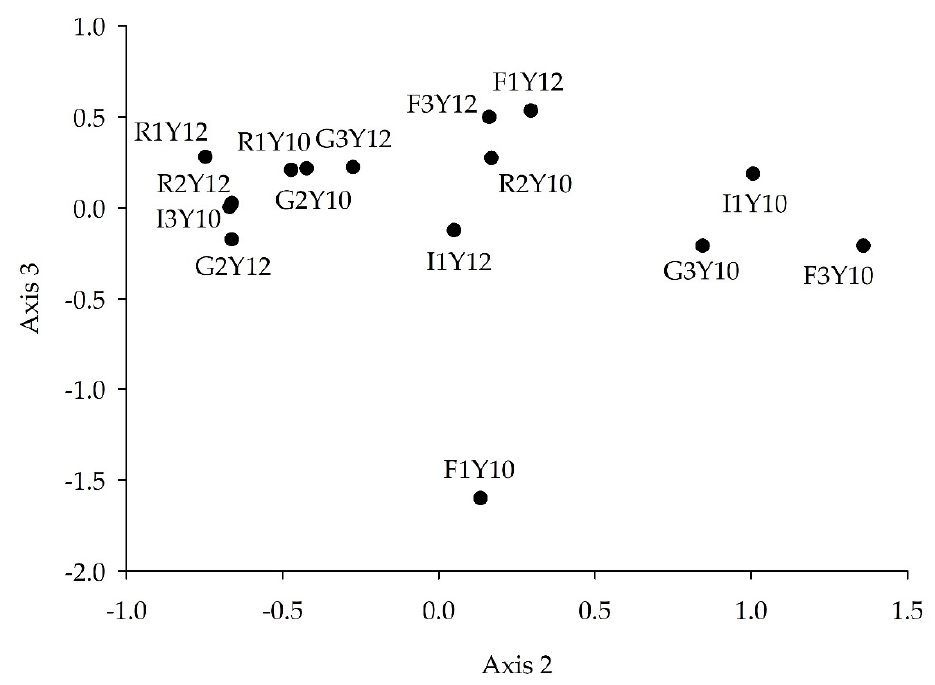
Figure 8. Axis 2 versus 3 (71% variance explained) reach sampling event distributions for the non- metric multidimensional scaling analysis of macroinvertebrate assemblages at 8 land-use/land-cover sites in 2010 and 7 sites in 2012 (F = Forest, G = Golf, I = Industrial, R = Residential; Y10 = 2010, Y12 = 2012).